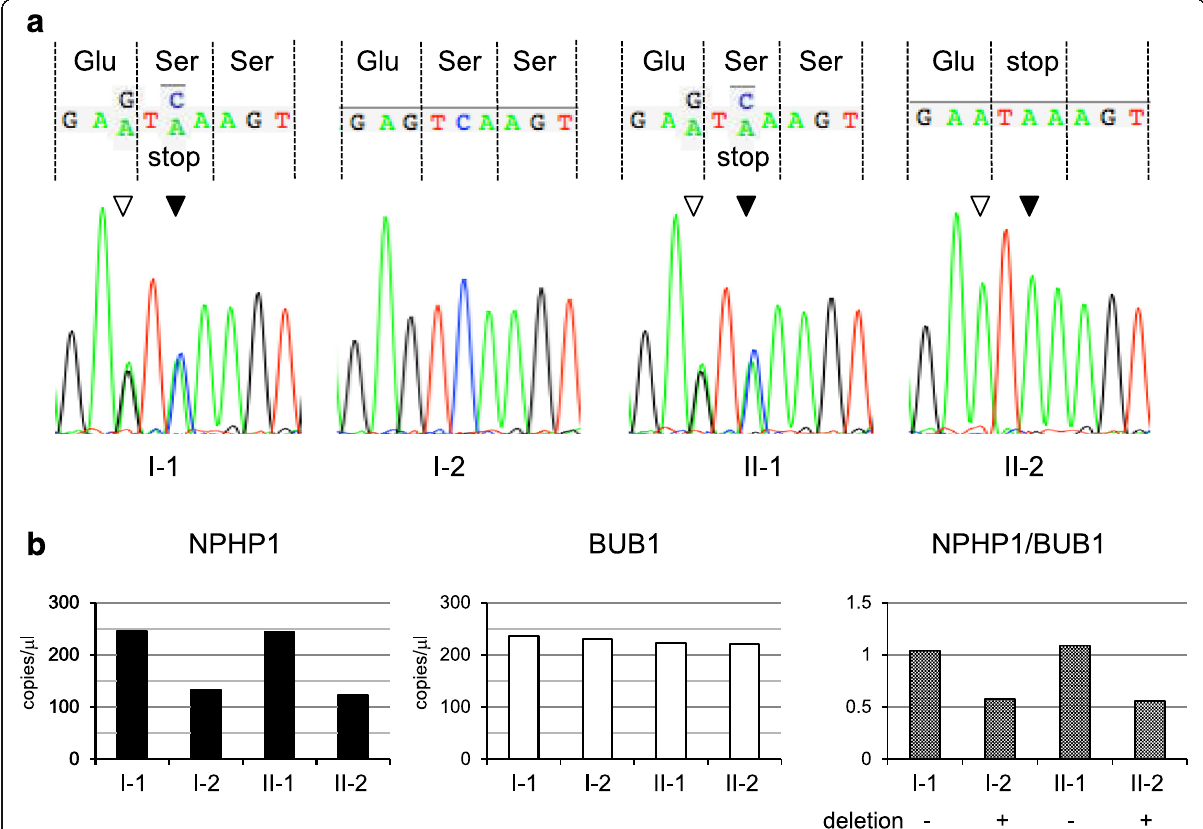
Fig. 2 a Electropherograms of DNA sequences from family member. Solid arrowhead indicates the c.656C>A mutation. Open arrowhead represents the single nucleotide polymorphism rs11675767. b Digital polymerase chain reaction targeted to NPHP1 and BUB1 . The number of copies of NPHP1 (left panel), BUB1 (middle panel), and the copy number ratios of NPHP1 to BUB1 (right panel) are